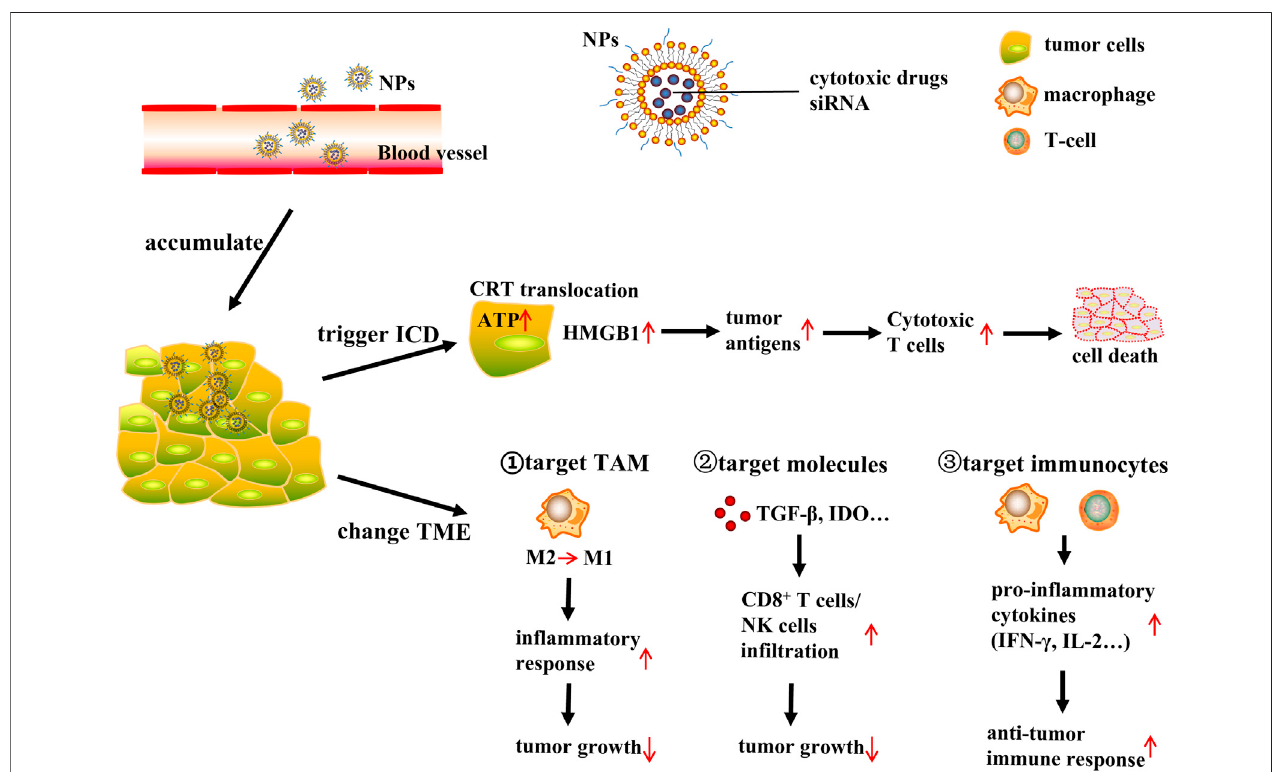
FIGURE 1 | NP-based delivery systems for cancer immunotherapy. NP (nanoparticles); ICD (immunogenic cell death); CRT (calreticulin); ATP (adenosine triphosphate); HMGB1 (high mobility group protein B1); TME (tumor microenvironment); TAM (tumor-associated macrophages). NP-based tumor targeted delivery systems deliver ICD inducing cytotoxic drugs or siRNA to tumor site, then NPs accumulate in the tumor interstitial space, further trigger ICD or change TME to induce immune response and fi nally lead to tumor cells death. NPs release ICD inducing cytotoxic drugs, inducing CRT translocate to cell surface, ATP release, and HMGB1 expression increase. This triggers tumor antigens process and produce cytotoxic T cells to induce tumor cells death. On the other hand, NPs delivery system could change TME through targeting TAM, immunosuppressive molecules and immunocytes respectively. Target TAM: NPs deliver drugs or siRNA to tumor cells, polarizing macrophages from M2 phenotype to M1 phenotype, and then stimulating in fl ammatory response, fi nally suppressing tumor growth. Target immunosuppressive molecules: NPs could act on TME related immunosuppressive molecules such as TGF- β and IDO, this will increase in fi ltration of CD8 + T cells and NKcells,resultingintumorgrowthinhibition.Targetimmunocytes:NPscoulddirectlyactonimmunecellssuchasmacrophagesandcytotoxicTcellsandthesecellswill produce pro-in fl ammatory cytokines including IFN- γ and IL-2, leading to antitumor immune response increase to suppress tumor